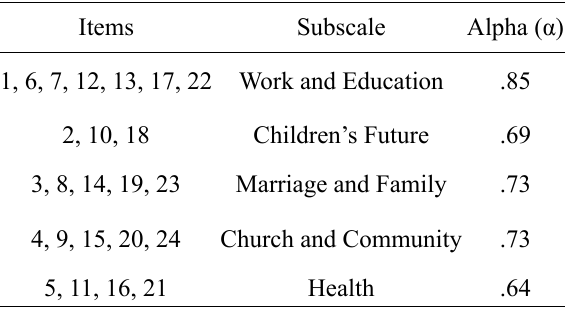
Subscales Reliability of the FESA Revised Measure in Chilean Adolescent Sample Items